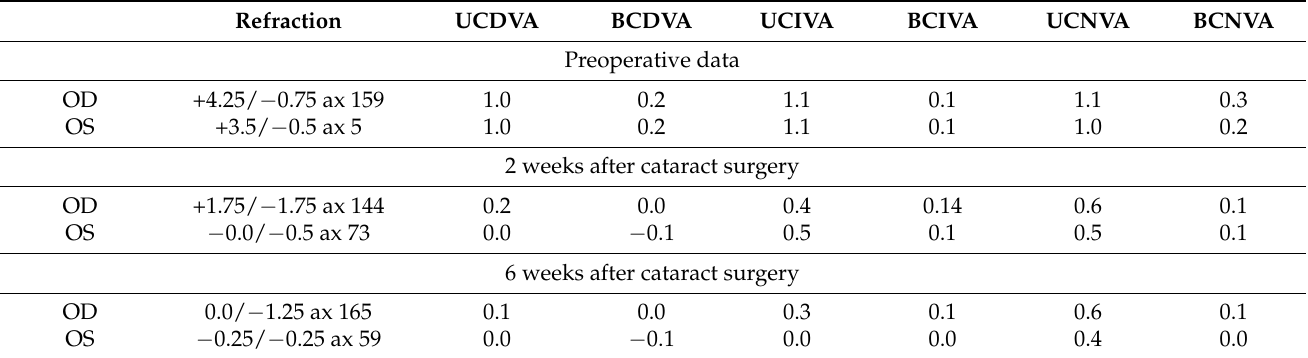
Table 1. Refraction and visual acuity (logMAR) before and after (2 weeks and 6 weeks) cataract surgery.